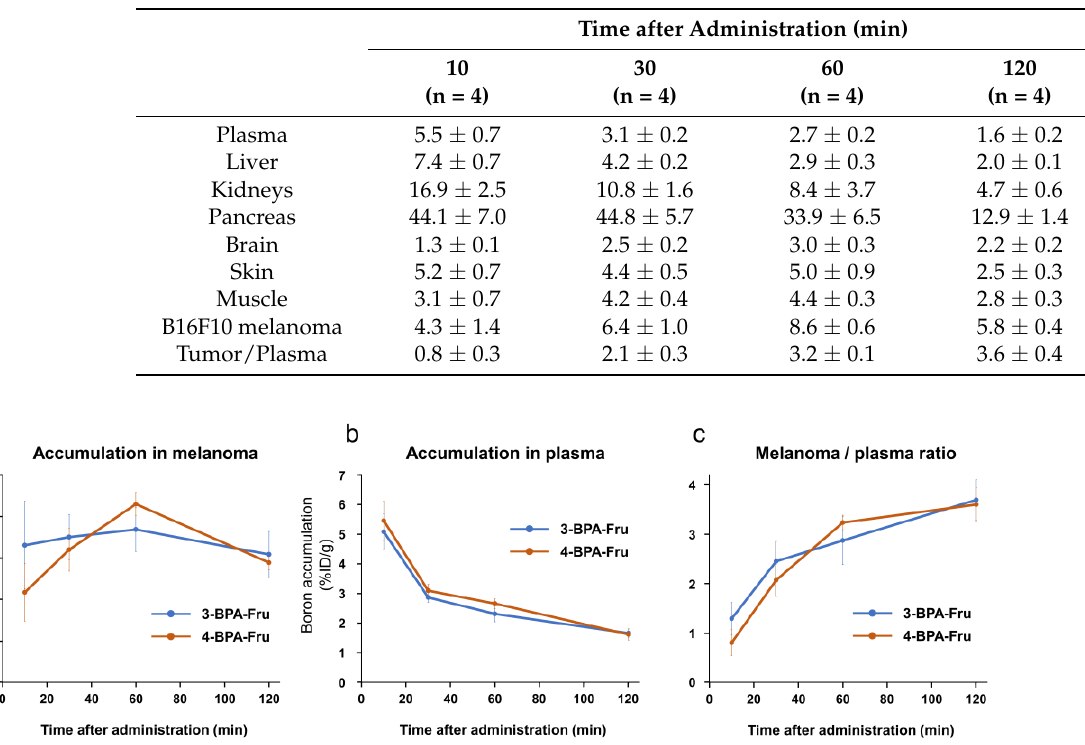
Table 3. Biodistribution of boron concentration after administration of 4-BPA-Fru in melanoma- bearing mice (%ID/g, n = 16).